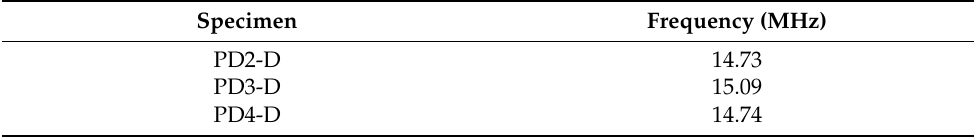
Table 7. Frequency of specimens corresponding to the − 3